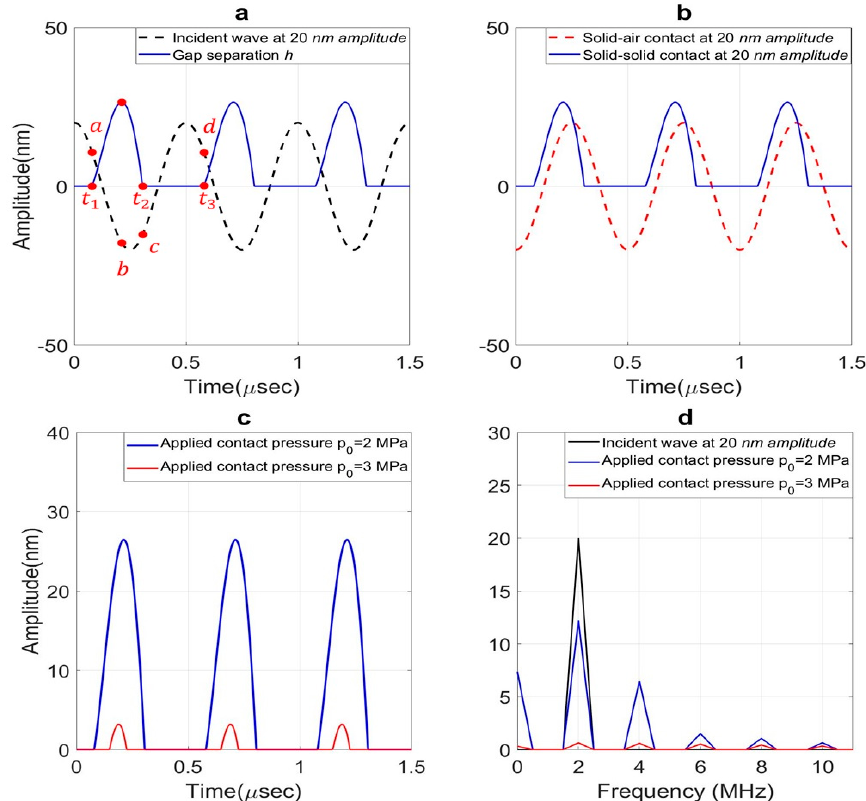
Figure 3. A theoretical approach for Contact Acoustic Nonlinearity (CAN) mechanics at incident wave amplitude 20 nm: ( a ) comparison between incident wave and gap separation h variation with time; ( b ) comparison between reflected wave from solid-air contact (reference signal) and solid-solid contact at 2 MPa; ( c ) effect of nominal contact pressure on reflected wave from solid-solid contact at 2 MPa and 3 MPa; ( d ) frequency spectrum comparison between incident wave, solid-solid contact at 2 MPa and 3 MPa.